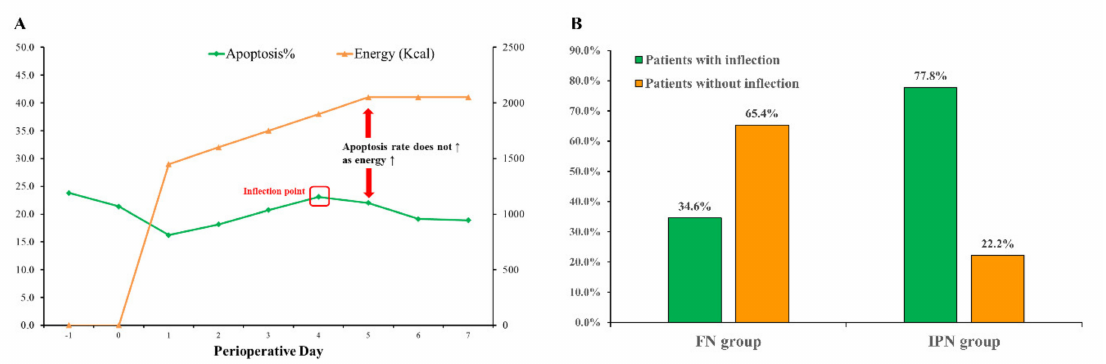
Figure 2. ( A ) Definition of inflection point (oral epithelial cell apoptosis rate does not increase with the increase of energy and fluctuates within 5%). ( B ) The percentage of patients experienced “inflection-point phenomenon” in the IPN group and FN